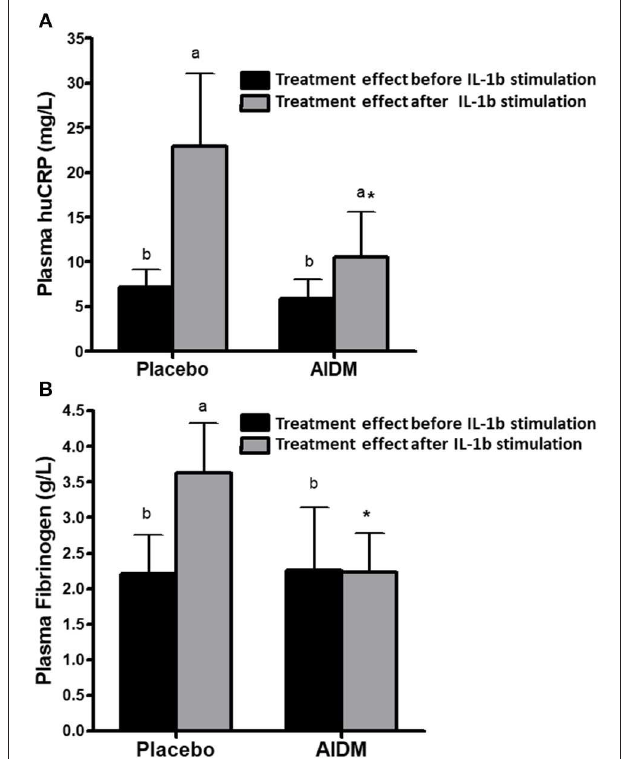
FIGURE 6 | The effect of an “anti-inflammation dietary mixture” (AIDM) vs. placebo quantified at fasting and after Il-1B stimulation on humanCRP (A) and fibrinogen (B) in transgenic mice. Mice were fed the AIDM and the inflammation markers were quantified after 6 weeks of treatment. The effects of AIDM vs. placebo were only visible after IL1B stimulation and not at fasting, showing the added value of applying a perturbation test to show treatment effects on inflammation. Adapted with permission from Verschuren et al.